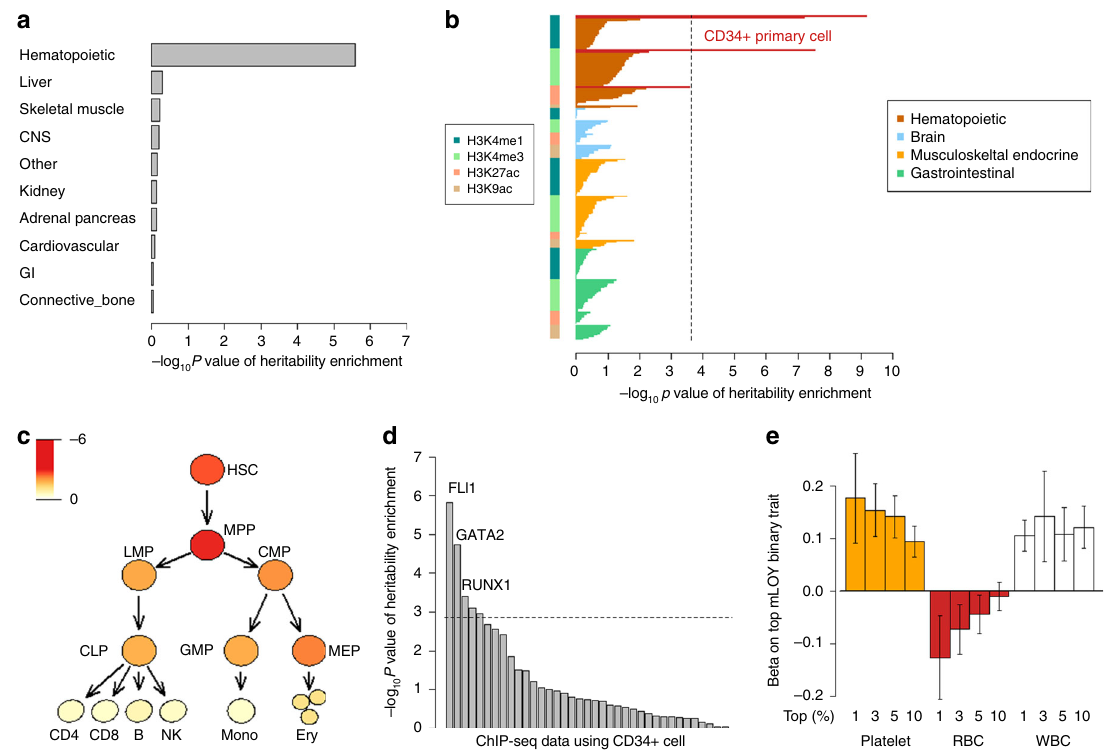
Fig. 3 Involvement of CD34 + HSCs and candidates of critical proliferation stage and transcription factor in mLOY. a Heritability enrichment of mLOY in ten cell groups evaluated by LDSC. The results of partitioning heritability for ten cell type groups with the use of ldsc are indicated. LD scores of the ten cell type groups are made based on LD scores of the fi ne cell types by the Finucane et al. The results are sorted by P -values. P -values of coef fi cient in ldsc are indicated for a – d . b Heritability enrichment of mLOY in 220 cell type-speci fi c annotations evaluated by LDSC. The cell types are classi fi ed into cell groups accordingly. CD34 + primary cells (HSCs) are given red color. A broken line indicates a signi fi cant threshold based on Bonferroni ’ s correction ( P < 0.05/ 220 cell type-speci fi c annotations). The results are sorted by (1) cell groups, (2) annotations, and (3) P -values. c Heritability enrichment of mLOY in detailed hematopoietic cell lineages, including CD34 + cells by LDSC-SEG. All of the cell types from HSC to CLP, GMP, MEP express CD34. The schema of differentiation from HSC is based on Corces et al. Brightness of the red color corresponds to strength of associations based on P -values (log 10 P). HSC hematopoietic stem cell, MPP multipotent progenitor, LMP lymphoid-primed multipotent progenitor, CMP common myeloid progenitor, CLP common lymphoid progenitor, GMP granulocyte/macrophage progenitor, MEP megakaryocyte/erythrocyte progenitor, CD4 CD4 + T cell, CD8 CD8 + T cell, B B